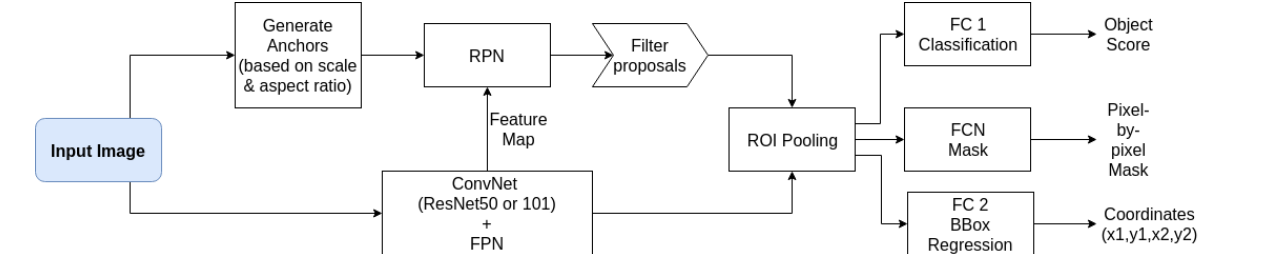
Figure 4. Workflow diagram of the applied Faster R-CNN